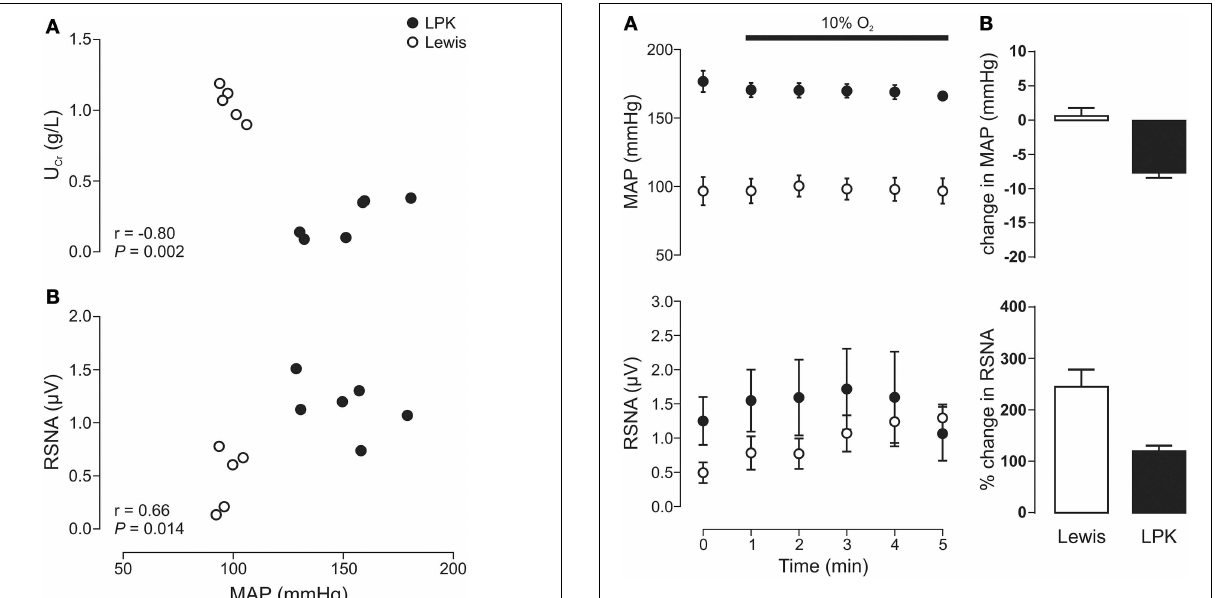
FIGURE 2 | Correlations of mean arterial pressure (MAP) vs. (A) urinary creatinine (U Cr ) and (B) renal sympathetic nerve activity (RSNA), in Lewis and Lewis Polycystic Kidney (LPK) rats derived from multiple linear regression ( n = 11 ). Pearson correlation coefficient (r) and significance are provided for each relationship within the figure panel.